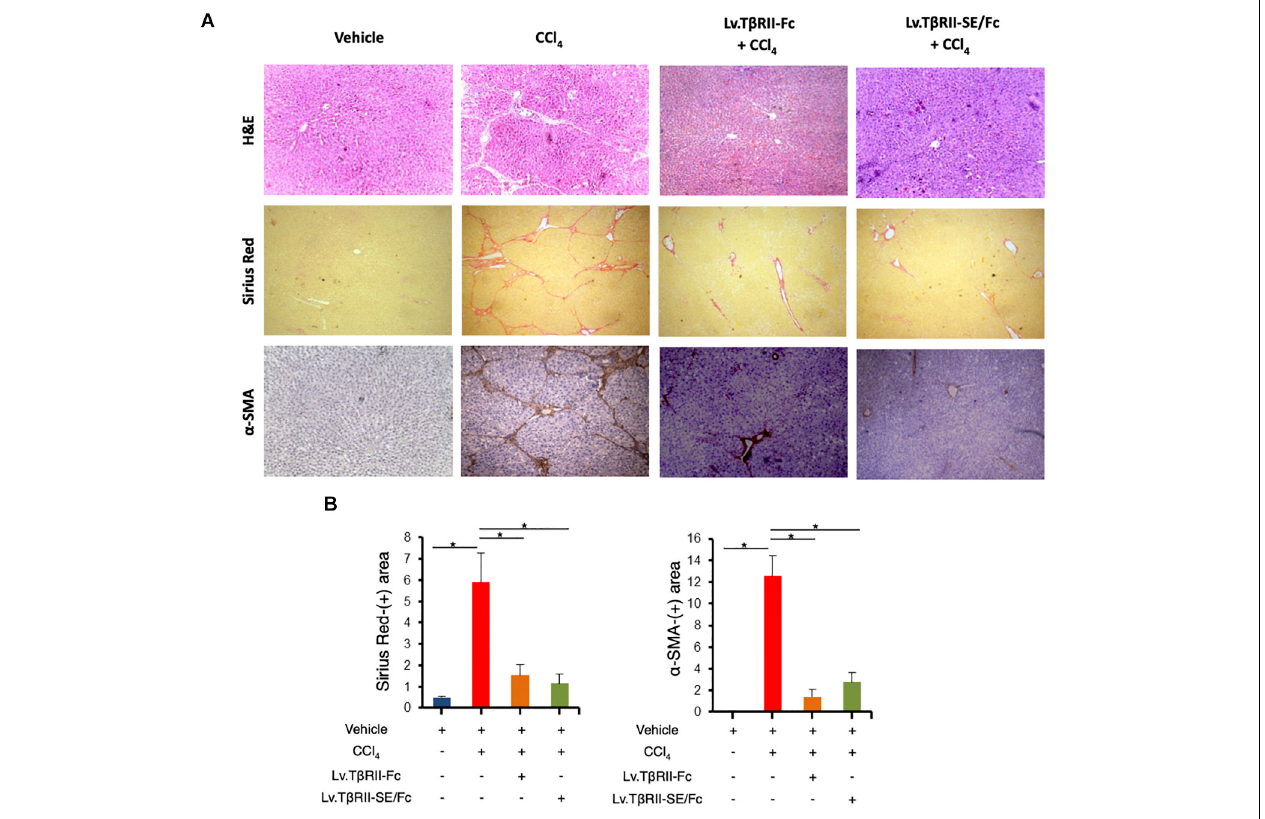
FIGURE 6 | T β RII-SE/Fc overexpression prevents CCl 4 -induced liver fibrosis development and HSC activation. (A) Representative images of liver sections stained with either H&E (top panel), Sirius Red (middle panel), and α -SMA immunohistochemistry of animals treated with vehicle, CCl 4 , Lv.T β RII-Fc + CCl 4 , or Lv.T β RII-SE/Fc + CCl 4 . Original magnification × 40. (B) Quantification of both liver Sirius Red positive areas (SR + ) (left panel) and liver α -SMA + expression (right panel) in the same experimental groups. Results are expressed as mean intensity of SR + area. * p < 0.05, Vehicle vs. CCl 4 , or CCl 4 vs. Lv.T β RII-SE/Fc + CCl 4 . HSC, hepatic stellate cells; H&E, hematoxylin and eosin; α -SMA; alpha-smooth muscle actin.